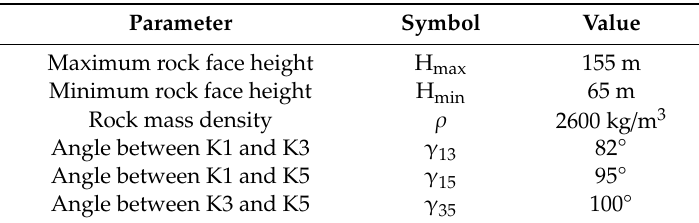
Table 3. List of parameters used for RBD analysis.